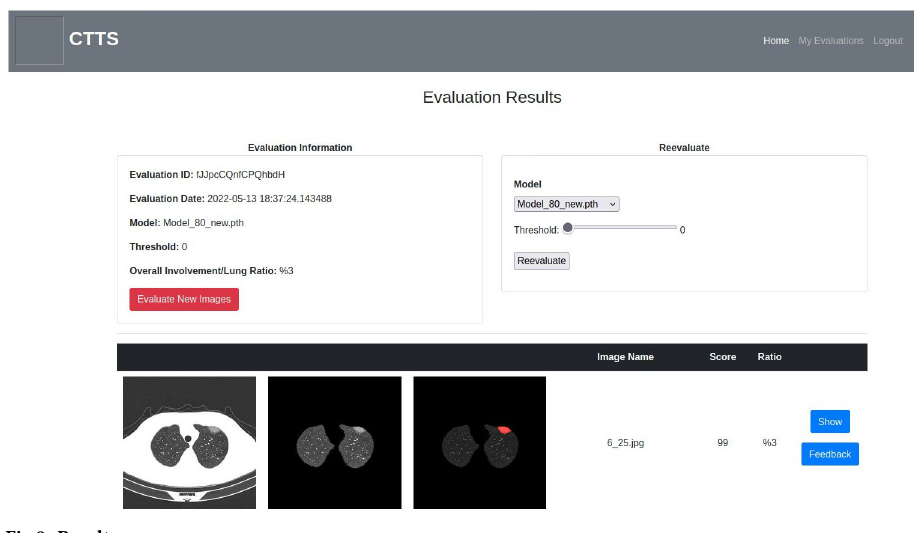
In the results page, which is shown in Fig 8, there are three sections. The upper left section contains evaluation ID and date, the used parameters, and the total Covid-19 affected area to lungs area ratio. The upper right section is used to re-evaluate the same images with different thresholds and models without re-uploading. In the lower section, there is a table with the fol- lowing columns—original image thumbnail, lungs image thumbnail, the thumbnail of the image with the found areas, image name, score, affected area-lungs area ratio, and two buttons which are used as shortcuts for the feedback and comparison pages. Users can also compare the original image and the masked image side-by-side via the show button. Users can annotate the masked image and give feedback about the evaluation on the feedback page shown in Fig 9. The feedback page is based on the simplified version of VGG Image Annotator (VIA) [68]. The annotated feedback is intended to be used for tune up to fur- ther improve the models. On ‘My Evaluations’ page (see Fig 10), each user can see their previ- ous evaluations and brief information about the evaluation such as ID, date, model, number of images and threshold.